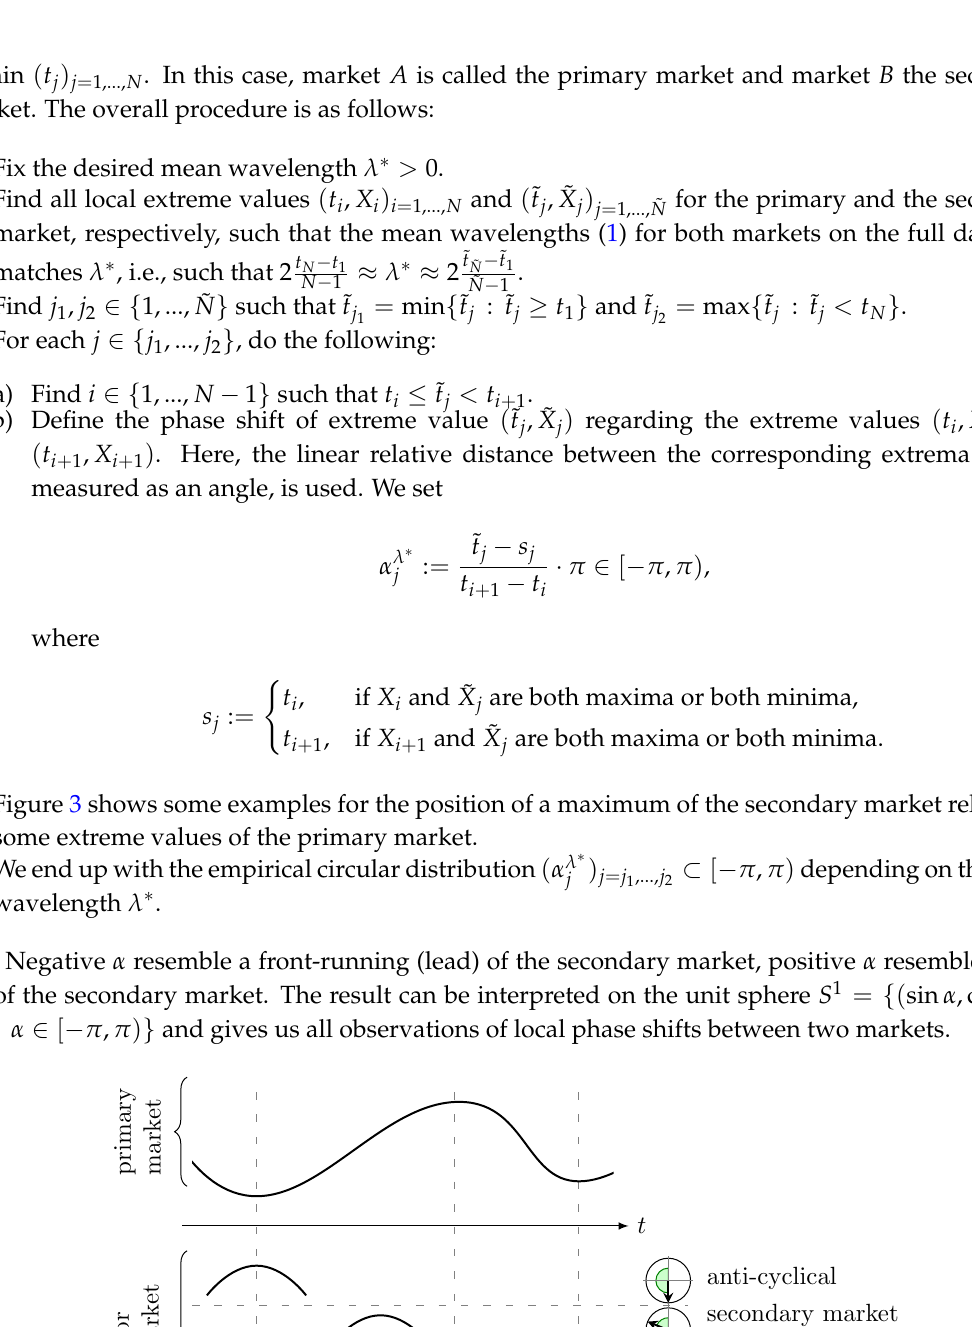
[ π , π ) measures their positions relative to ∈ −